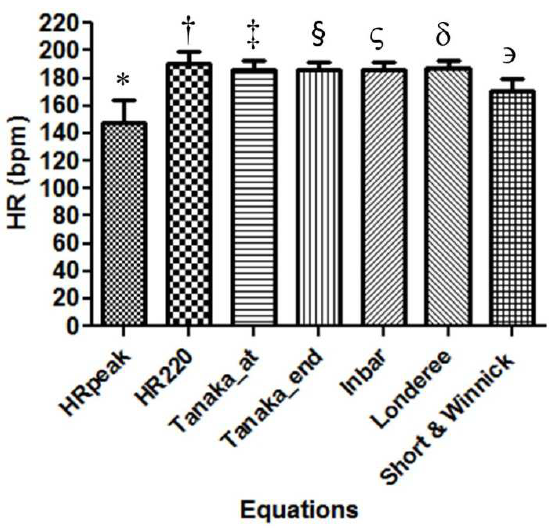
Figure 3: Heart rate values ( (cid:1)̅ ±SD) obtained during YYIRT1 (HRpeak) and equations for predicting HRmax. *Significant difference between HRpeak and others equations; † HR220 and others equations; ‡ TNK-At and others equations; § TNK-End and others equations; ς INB and others equations; δ Londeree and others equations; ∋ Short and Winnick and others